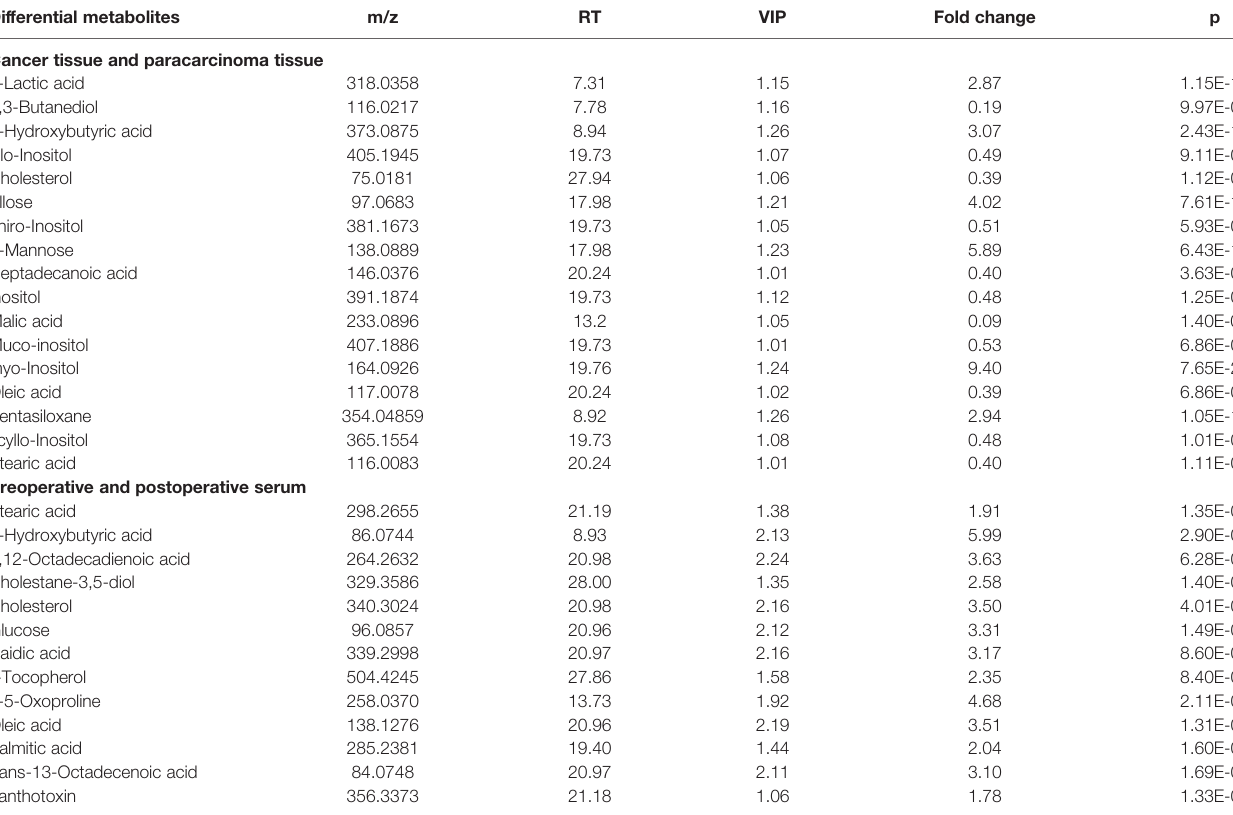
TABLE 2 | The identi fi cation of potential biomarkers in tissue level based on GC-MS. Differential metabolites m/z RT VIP Fold change Cancer tissue and paracarcinoma tissue L-Lactic acid